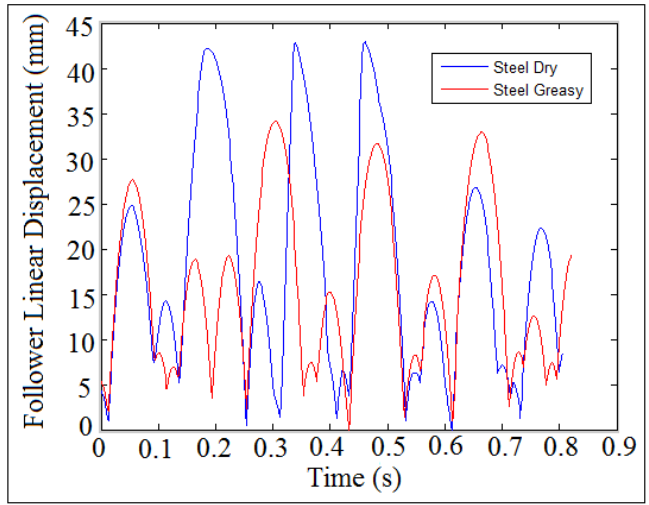
Figure 47. Follower linear displacement against time at (I.D. = 19 mm) and (N = 1000 rpm) using different types of contacts.